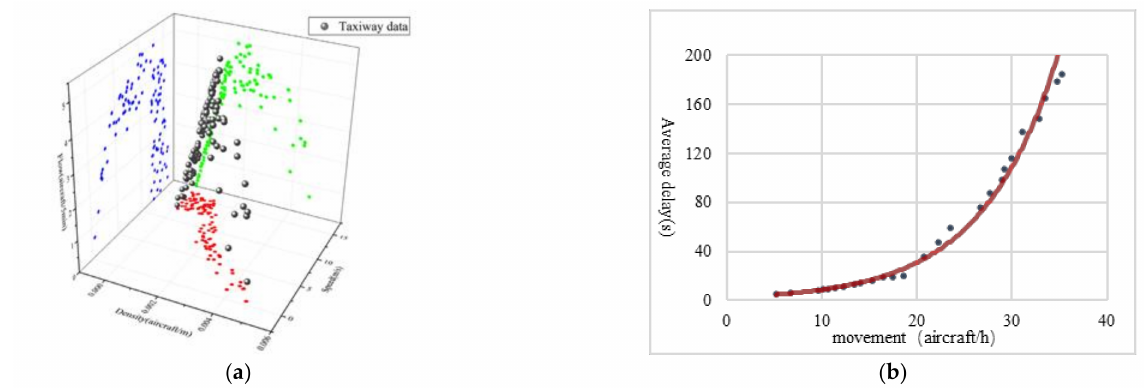
Figure 2. The fundamental diagrams of traffic flow congestion: ( a ) speed-density-flow relations of taxiway traffic flow; ( b ) active movement and average delay relationship for apron area